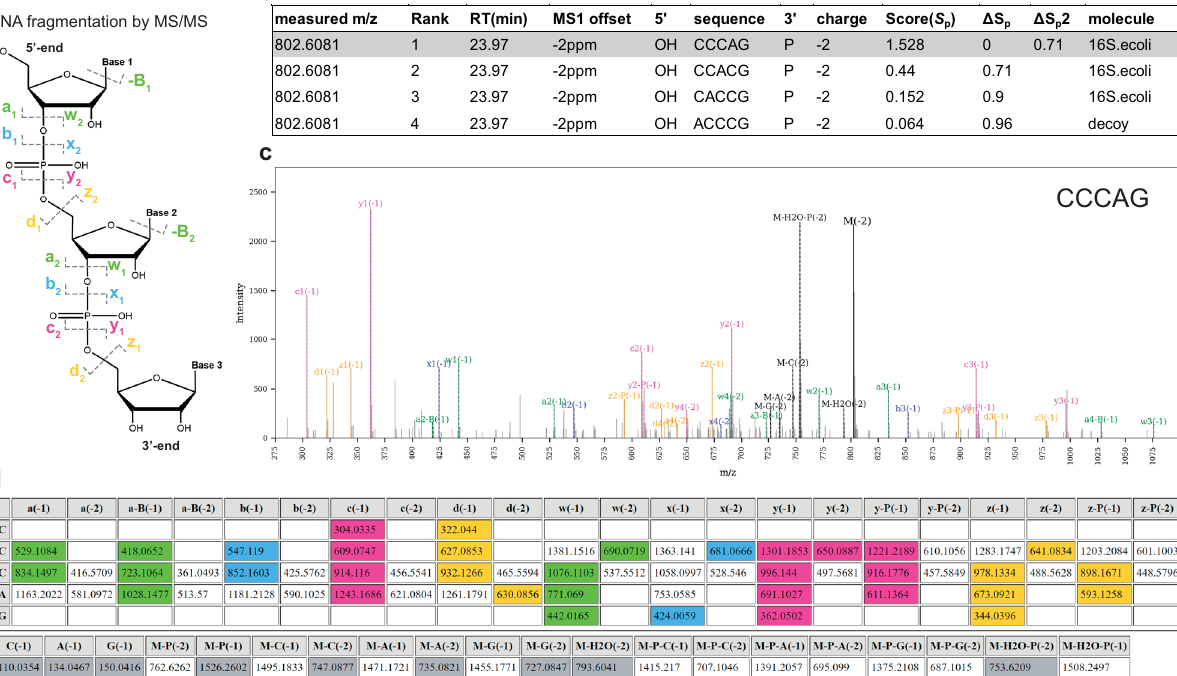
Fig. 2 RNA fragmentation and MS2 spectra matching, scoring, and visualization in Pytheas. a McLuckey nomenclature of RNA product ions following CID fragmentation 16 . RNA can be cleaved at each of four bonds of the phosphodiester backbone, producing nine major fragment ion series (a/a-B/b/c/d/ w/x/y/z) commonly observed in CID spectra under negative ionization. b Competing OSMs for a given precursor ion scored and ranked by Pytheas. c MS/ MS spectrum of the top scoring OSM highlighted in the panel ( b ). d Summary table of all the predicted and matched (highlighted in color) fragment ions, with theoretically calculated m/z values. In ( c ) and ( d ) sequence-de fi ning fragment ions are highlighted using the same color scheme as in panel ( a ). ( c ) and ( d ) have been rendered via Pytheas visualization